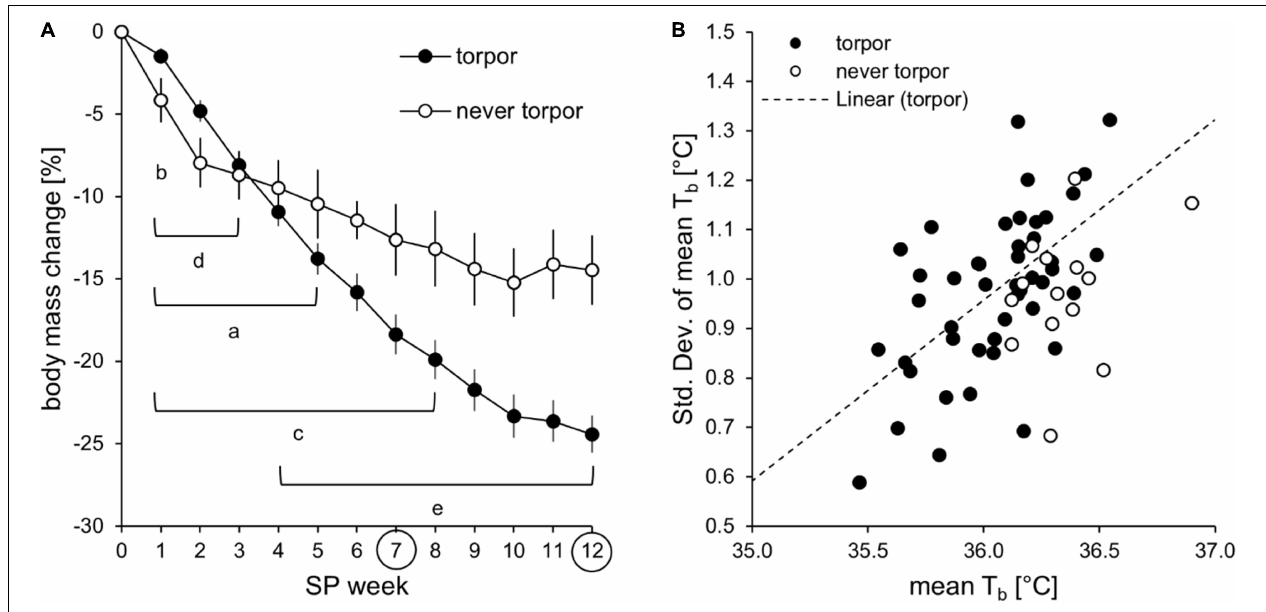
FIGURE 5 | Comparison of hamsters with and without torpor expression of approach 1. (A) Mean ( ± standard error) relative body mass change during adaptation to the short photoperiod [ n torpor = 46, n never torpor = 14]. Significant differences to SP07 of “torpor” ( a ) and “never torpor” ( b ) hamsters. Significant differences to SP12 of “torpor” ( c ) and “never torpor” ( d ) hamsters. Significant differences between “torpor” and “never torpor” hamsters ( e ) [two-way repeated measures ANOVA: F ( 11 , 638 ) = 10.124, p < 0.001, with Holm–Sidak p < 0.001]. (B) Correlation of the mean body temperature and its standard deviation during the middle of scotophase. The higher the mean body temperature, the lower is its standard deviation in “torpor” hamsters ( n = 46, with R 2 = 0.3489, r = 0.591, p < 0.050). This correlation could not be confirmed in “never torpor”